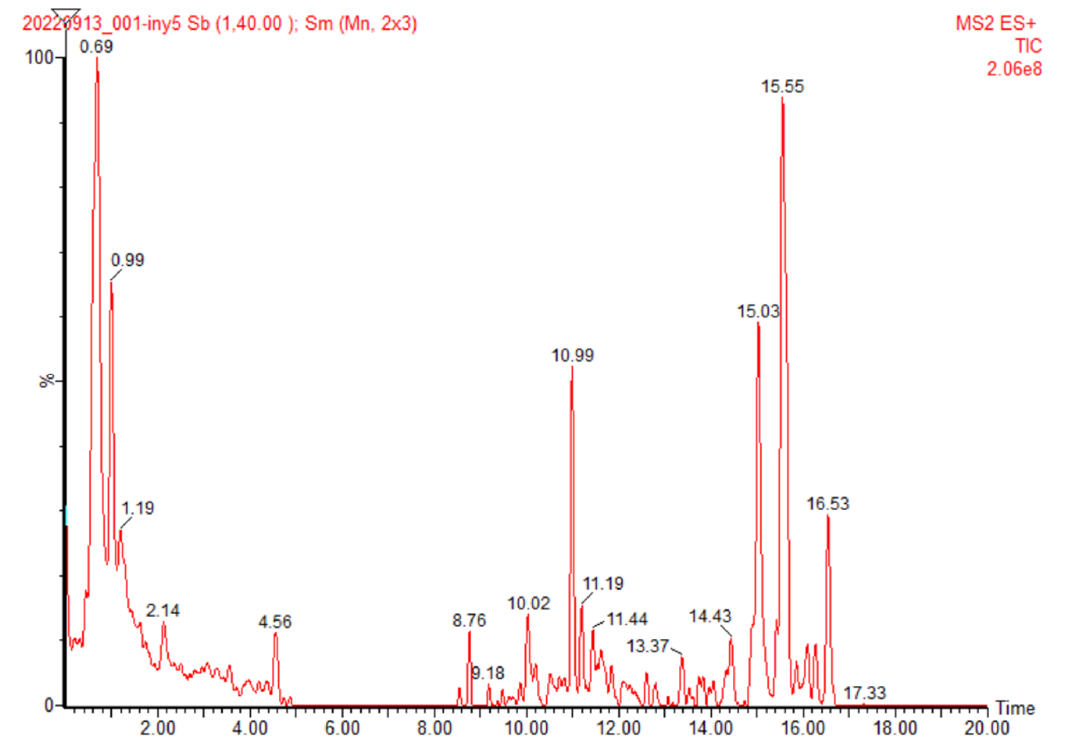
Figure 3. Peak chromatogram for an aqueous solution of mucilage extracted from yellow pitahaya fruit peels obtained by UPLC-QTOF-MS/MS.